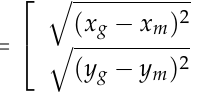
Table 8 presents the position estimation results. Coordinates ( x m , y m ) were calculated from θ m 1 and θ m 2 based on the proposed method (21). The error values E x and E y were calculated from the following.